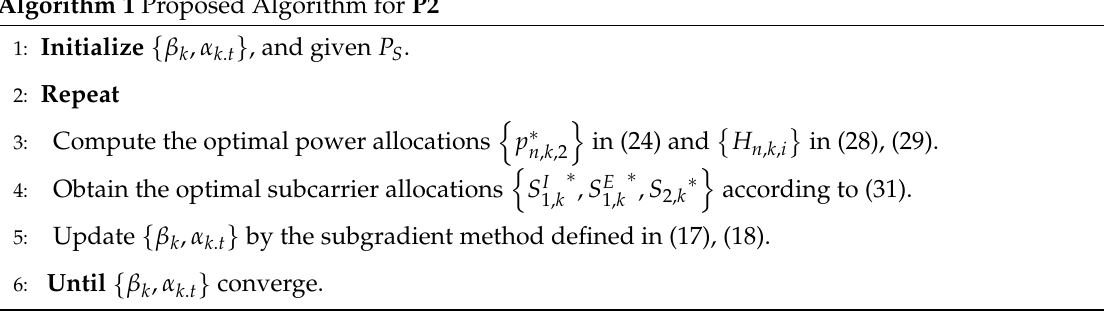
Algorithm 1 Proposed Algorithm for